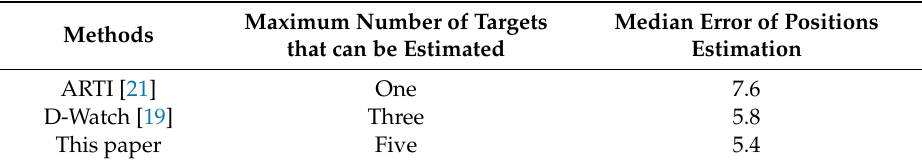
Table 5. Comparison with recent works.